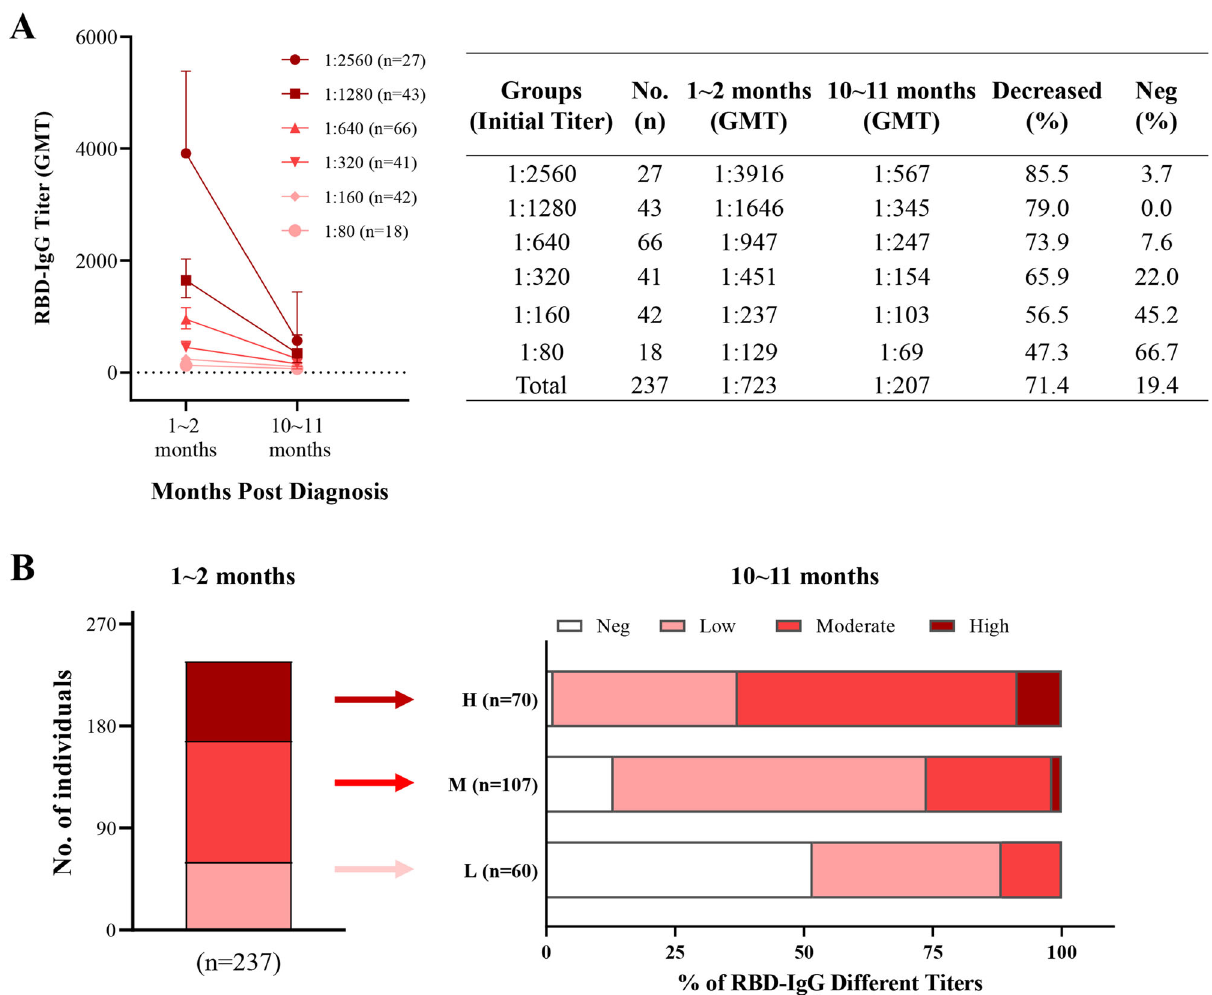
Fig. 3 Stability of RBD-IgG titers over time. A Changes of different RBD-IgG titers over time. The titer is expressed by Geometric Mean and Geometric SD. A total of 237 COVID-19 convalescent plasma donors with different titer levels of RBD-IgG at the early stage, who have donated plasma again at the 10th and 11th months, stratify with titers at the early stage following diagnosis, and the decline in titers and the proportion of plasma donors turning into negative are calculated. GMT: Geometric mean titer. Initial titer: RBD-IgG titer at the early stage (1st and 2nd months after diagnosis). B Change of RBD- IgG titers in plasma donors with low, moderate, or high titers after a long period of time. Neg (negative), titers less than 1:80. Low (low titers, L), titers